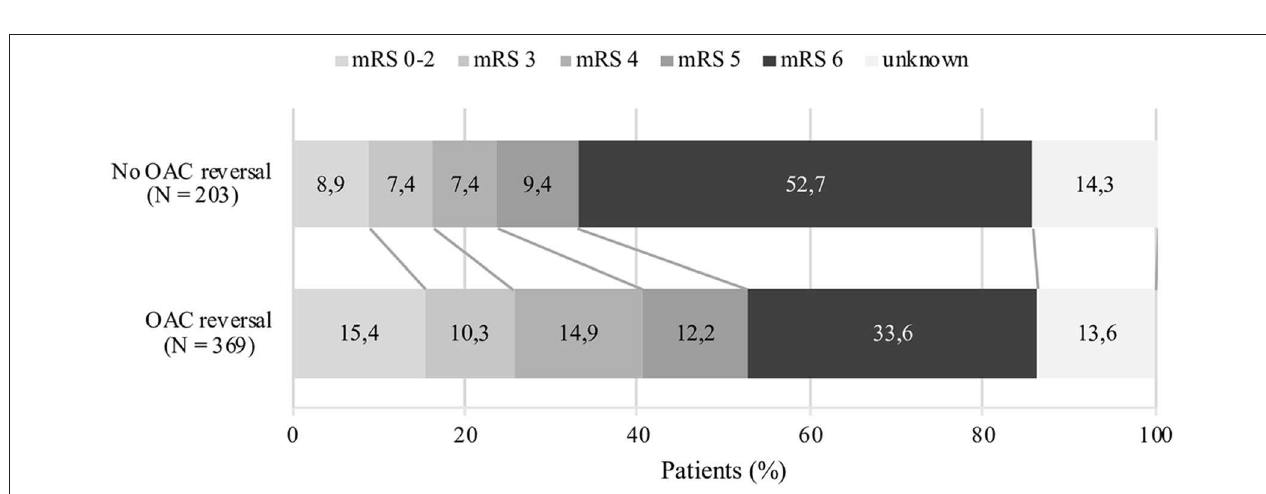
FIGURE 3 | Crude data comparing 90-day functional outcome following oral anticoagulant related intracerebral hemorrhage. Figure includes patients lost to follow-up. VKA, vitamin K antagonist; NOAC, non-vitamin K antagonist oral anticoagulant.